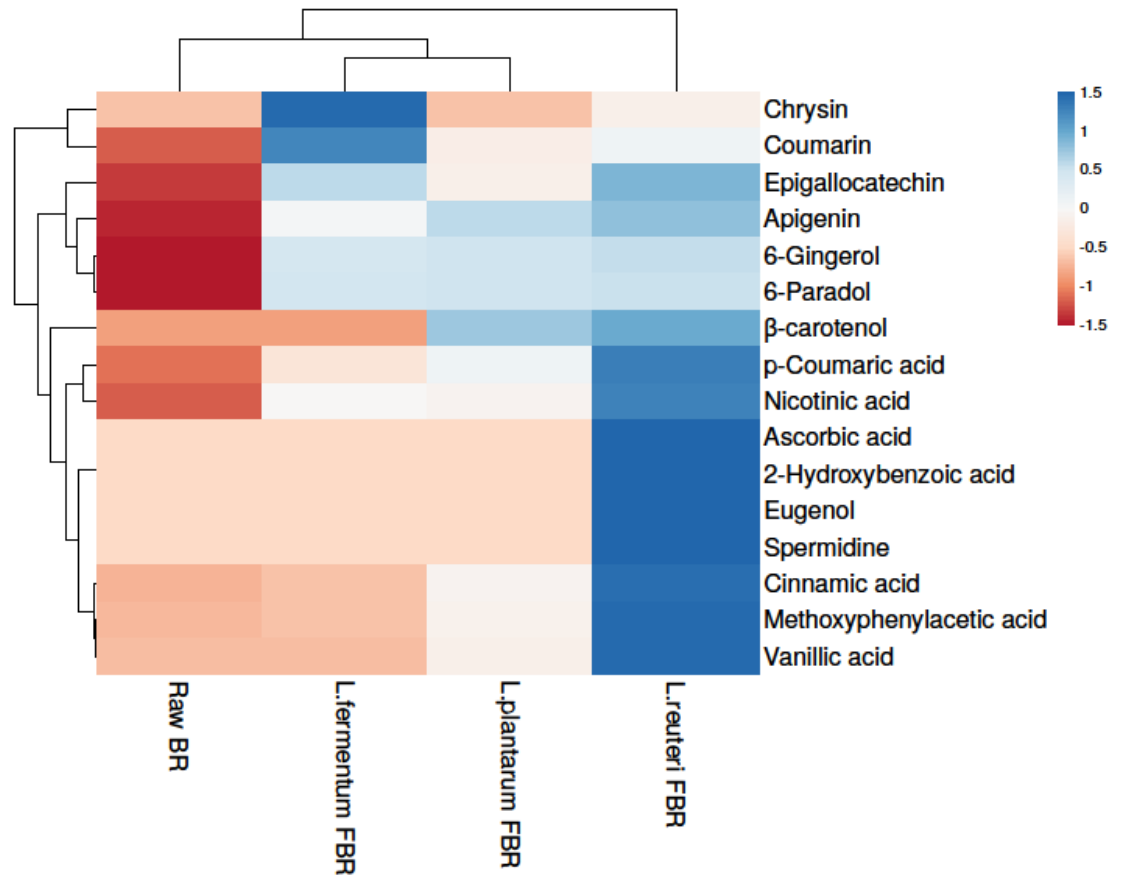
Figure 1. Heat map showing levels of phenolic compounds in raw and LABs fermented BR samples.